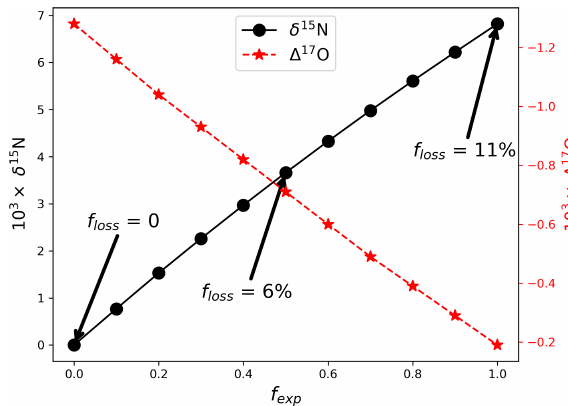
)/(cid:49) 17 O ( NO 3 ) Figure 4. Sensitivity of annual mean δ 15 N ( NO − 3 upon archiving to f exp . Positive/negative values indicate the devia- tions of F pri . Note when f exp is set to 1, the small non-zero value ( − 0.19‰) of (cid:49) 17 O ( NO − ) represents the effects of the cage 3